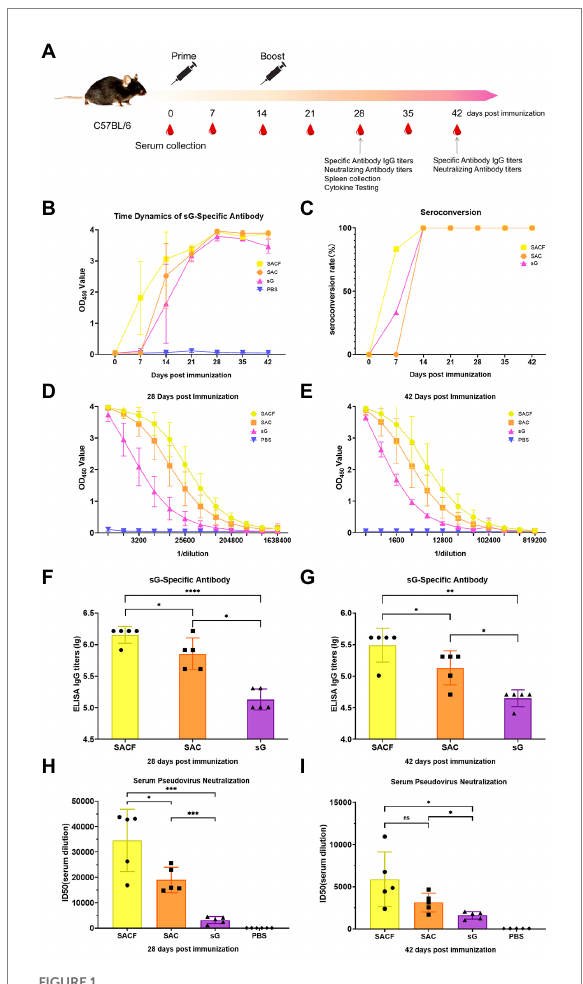
FIGURE 1 Vaccine candidate induced humoral response in the C57/BL6 mouse model. (A) Immunization procedure and vaccine candidate efficacy evaluation in mice. (B) OD value of